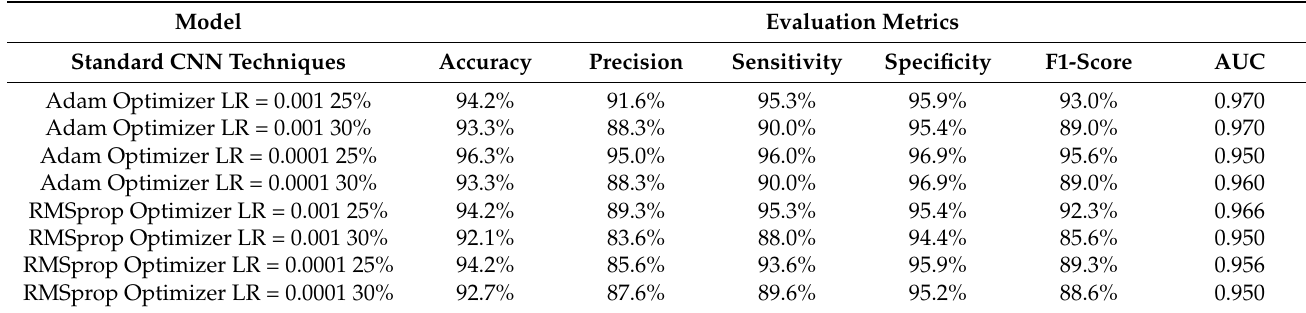
Table 1. The evaluation metrics of three classes average with our standard CNN model.